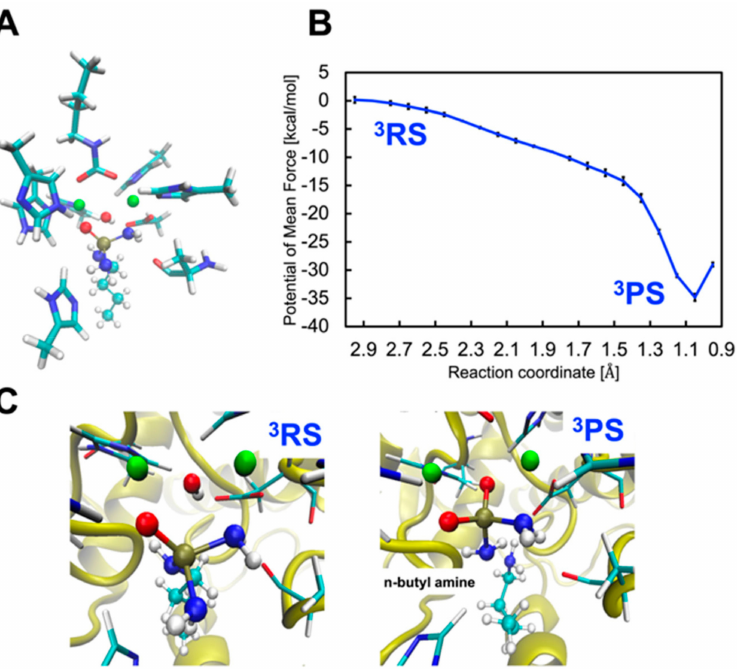
Figure 4. ( A ) QM region of NBPTO-bound complex ( 3 RS ) obtained with the QM/MM MD equilibra- tion; ( B ) one-dimensional potentials of mean force (1D-PMFs) for the release of n -butylamine and the DAP-inhibited complex formation step; and ( C ) representative snapshots of the active sites in 3 RS and 3 PS